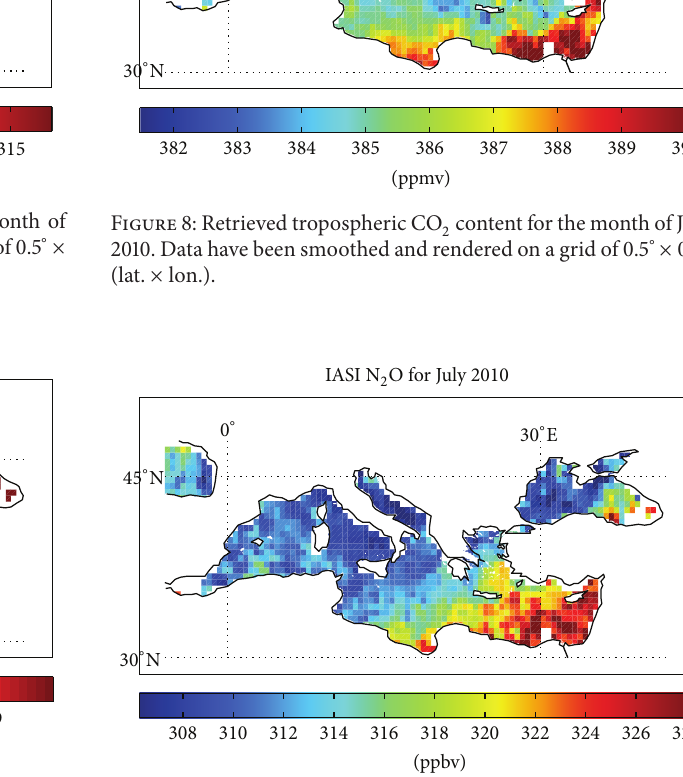
Figure 7: Retrieved sea surface temperature for the month of July 2010. Data have been smoothed and rendered on a grid of 0.5 ∘ × 0.5 ∘ (lat. × lon.).